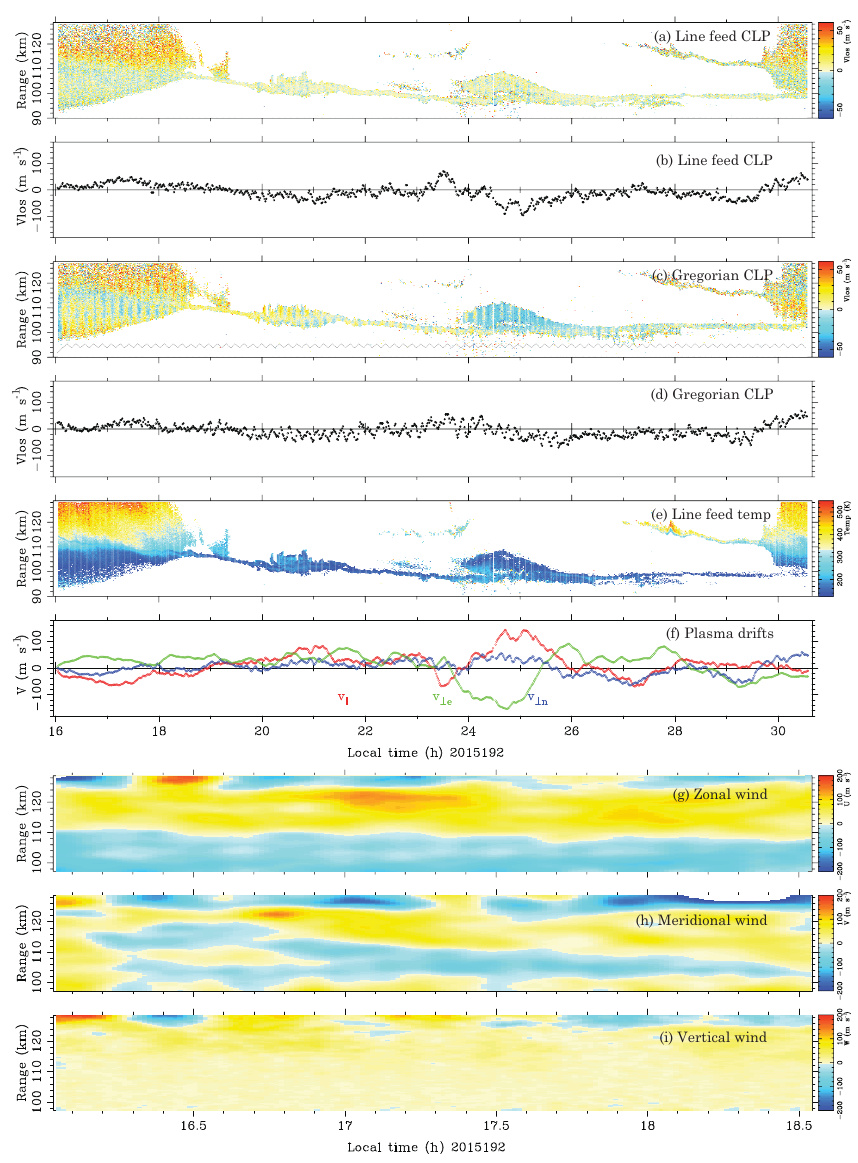
Figure 2. Detailed examination of the Arecibo dataset from 11/12 July 2015. The panels are described in the text.